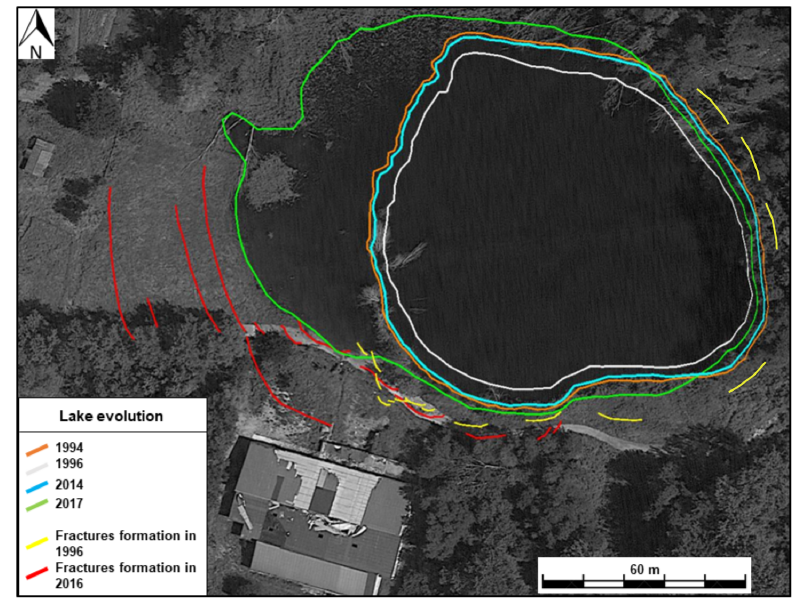
Figure 3. Evolution of the Prà di Lama lake between 1994 and 2017. Lake shore variation has been retrieved from the analysis of the Landsat image.